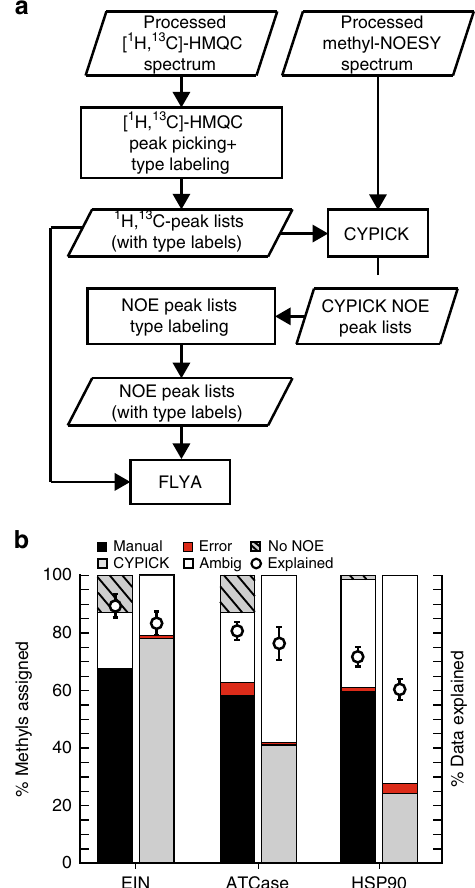
Fig. 4 MethylFLYA performance with automatic peak picking using CYPICK. a An outline of the combined CYPICK-MethylFLYA assignment protocol (see Methods). “ Type labeling ” refers to the attribution of methyl resonances to amino-acid types (e.g. Ala, Ile, Leu, Val). b Comparison of MethylFLYA performance on manually and automatically picked NOESY data. The percentage of assigned methyl resonances and the percentage of explained input NOESY data, given the MethylFLYA assignment, are shown. The error-bars are standard deviations of the percentage of data explained over the three distance cutoffs (optimal cutoff ±0.5 Å, see Methods). Note that CYPICK does not assign methyl – methyl NOEs, and hence the identity of the methyl resonances with no NOEs ( “ no NOE ” ) is not indicated for